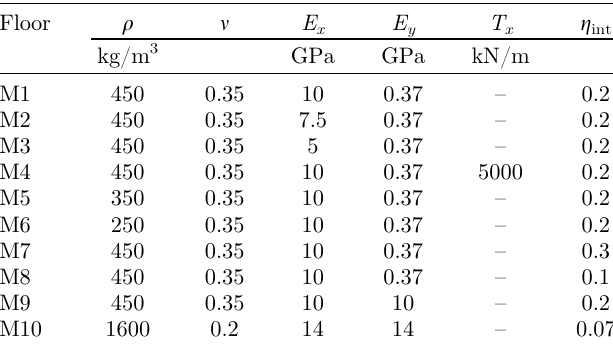
Table 1. Material parameters of the 10 simulated fl oors used in the listening test.